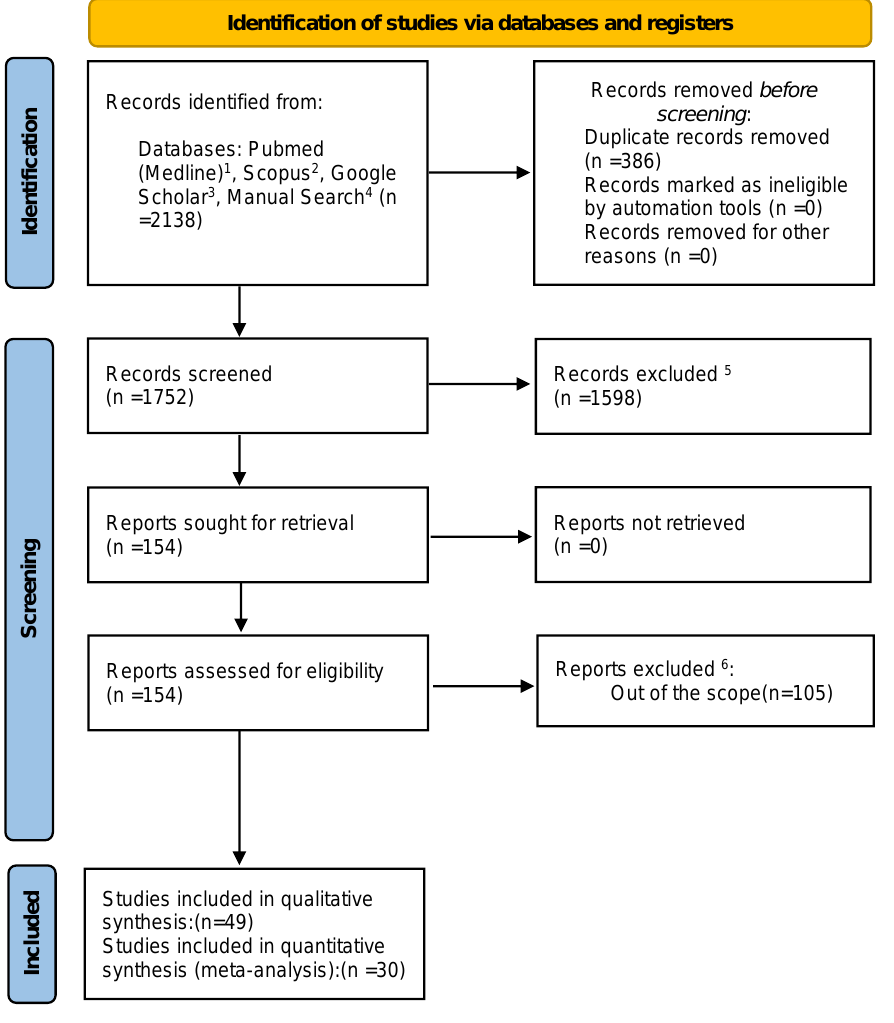
Figure 1. The flow chart of the search.